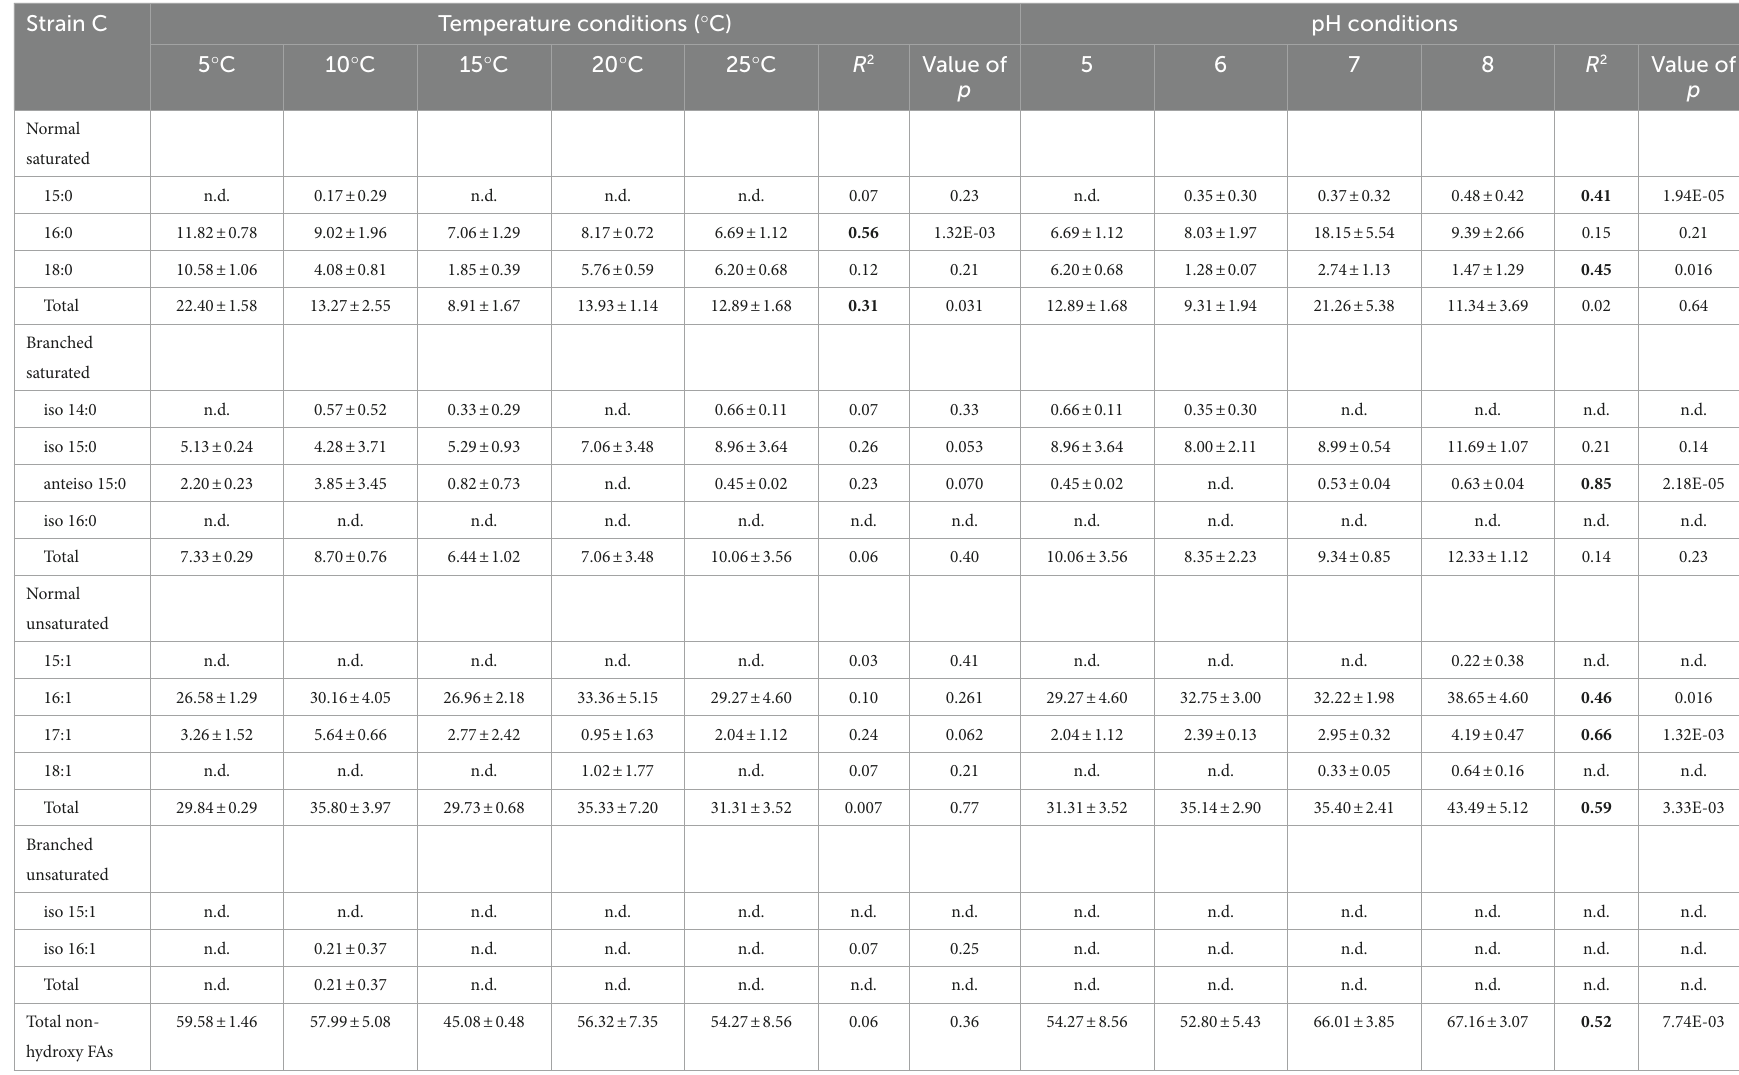
TABLE 3 Relative percentage abundances of non-hydroxy fatty acids vs. total fatty acids for strain C under different temperature conditions (at pH 5) and at different pH conditions (at 25 ° C). Strain